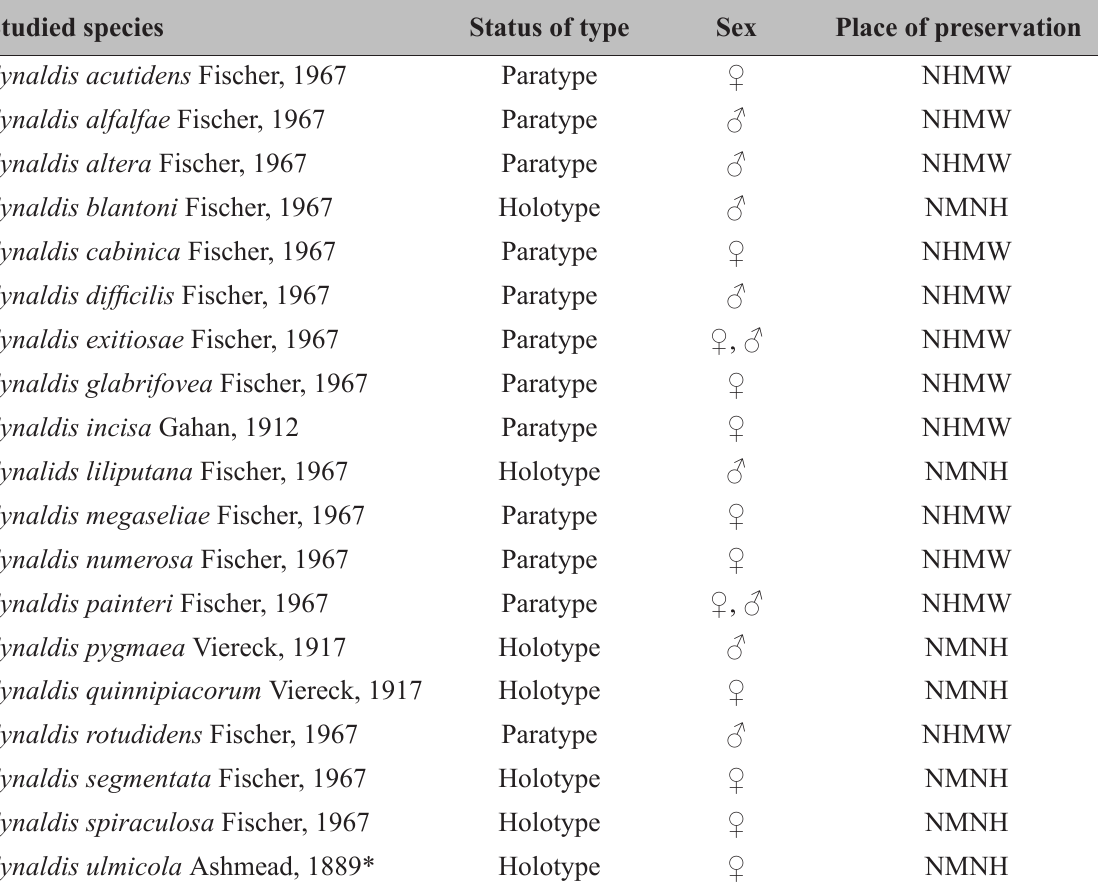
Table 1. A list of studied type material of the previously described New World species and place of their preservation. * This species was originally described as Synaldis ulmicola by Ashmead (1889), however Fischer (1967b) placed it in the genus Aspilota as Aspilota ulmicola . After revision of the holotype we consider it to belong within the genus Synaldis by the absence of vein